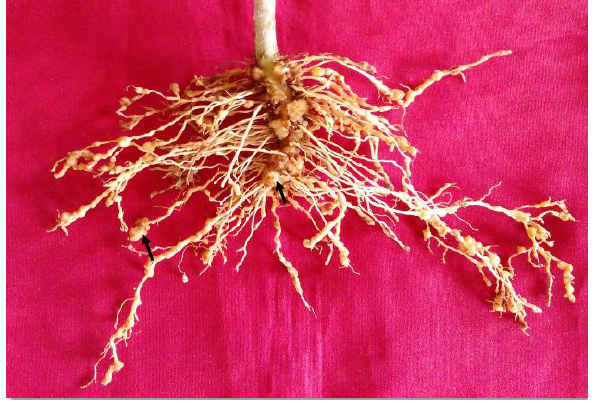
Figure 1b: Below ground symptom of root-knot nematode (Naanaattan, Mannar)